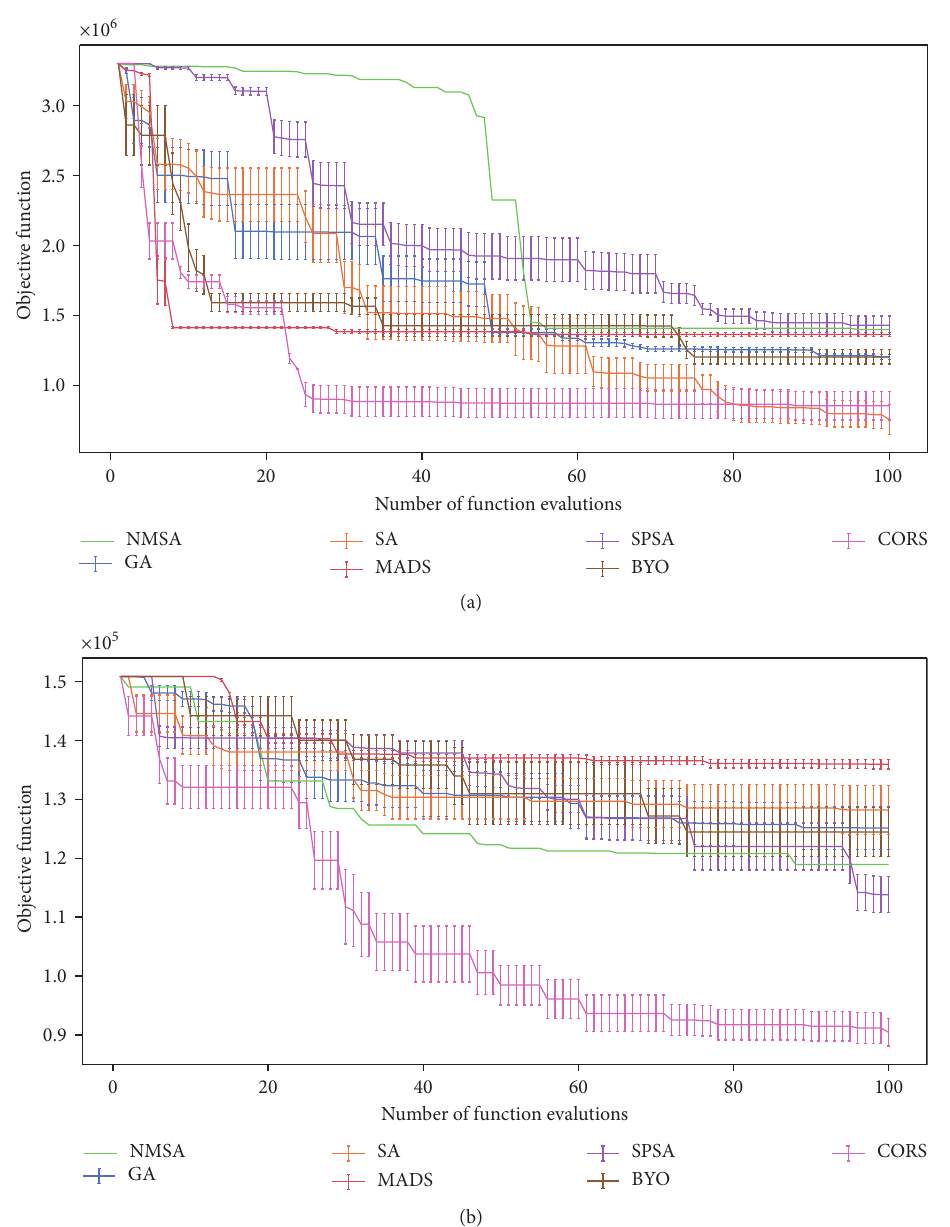
Figure 4: Algorithm performance in the two path choice scenarios. (a) Random. (b)